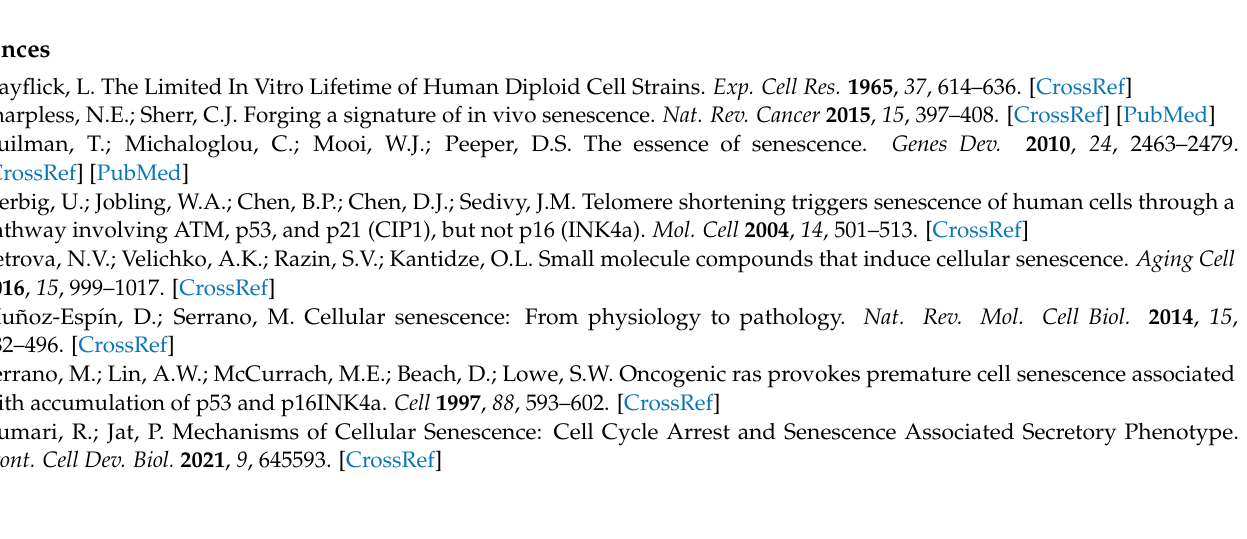
Table S2: Sequences of siRNA and miRNA mimics, Table S3: miRNA target prediction platform used in this study; Table S4: List of differentially expressed miRNAs targeting